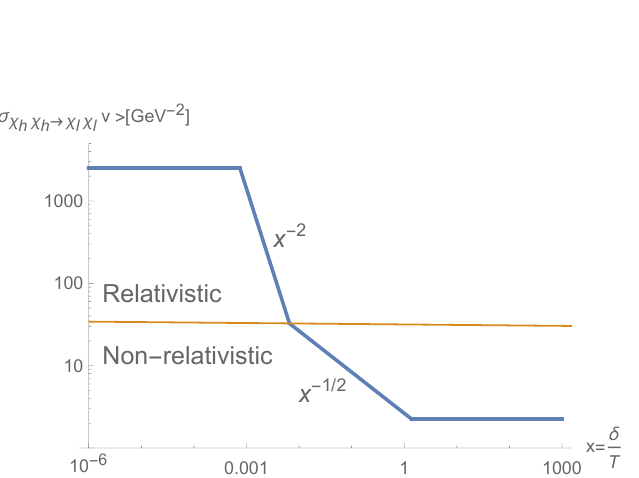
Figure 17 . Thermally averaged cross section for a DM mass of 10 MeV, mass splitting of 10 − 2 MeV, . Again, we observe that for both high and low temperatures the cross α D = 0 . 5 , and m A 0 = 5 m χ l section is constant and in the middle has a non-trivial dependence on x